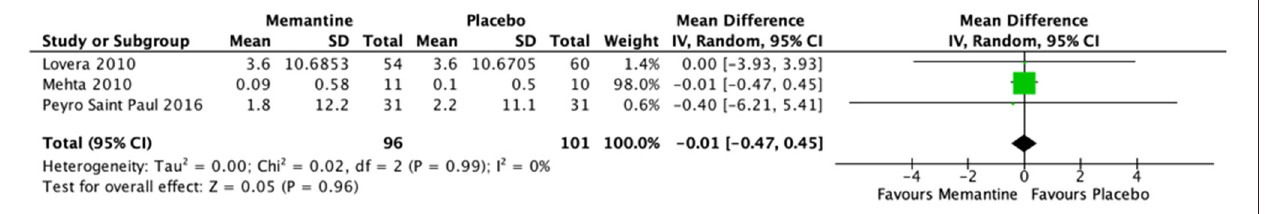
FIGURE 3 | Forest plot of mean difference in PASAT scores for studies comparing memantine and